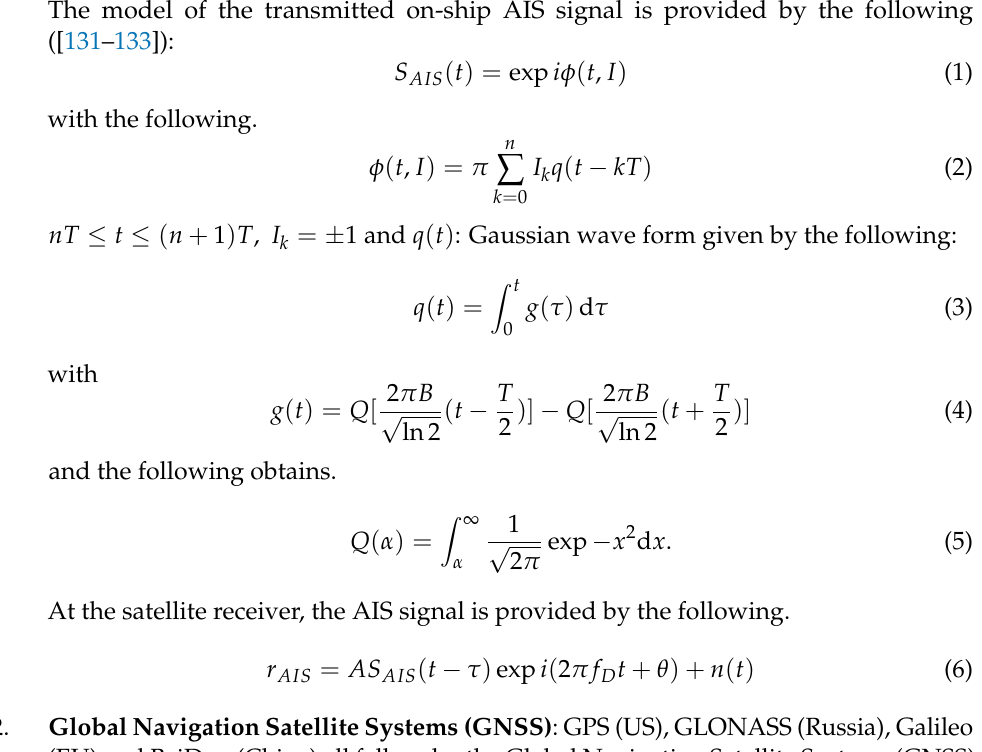
Global Navigation Satellite Systems (GNSS) : GPS (US), GLONASS (Russia),